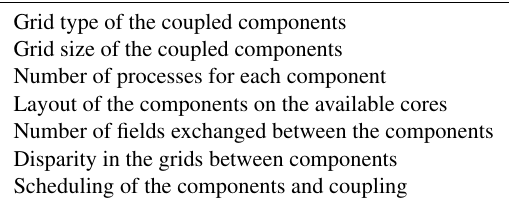
Table 2. A set of characteristics that influence coupler performance. Grid type of the coupled components